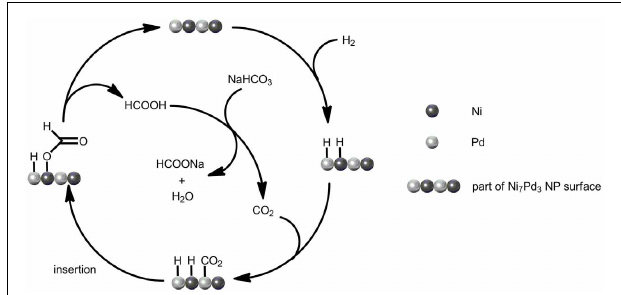
FIGURE 5 | Proposed reaction mechanism of CO 2 hydrogenation into formate over Ni7Pd3 NPs.